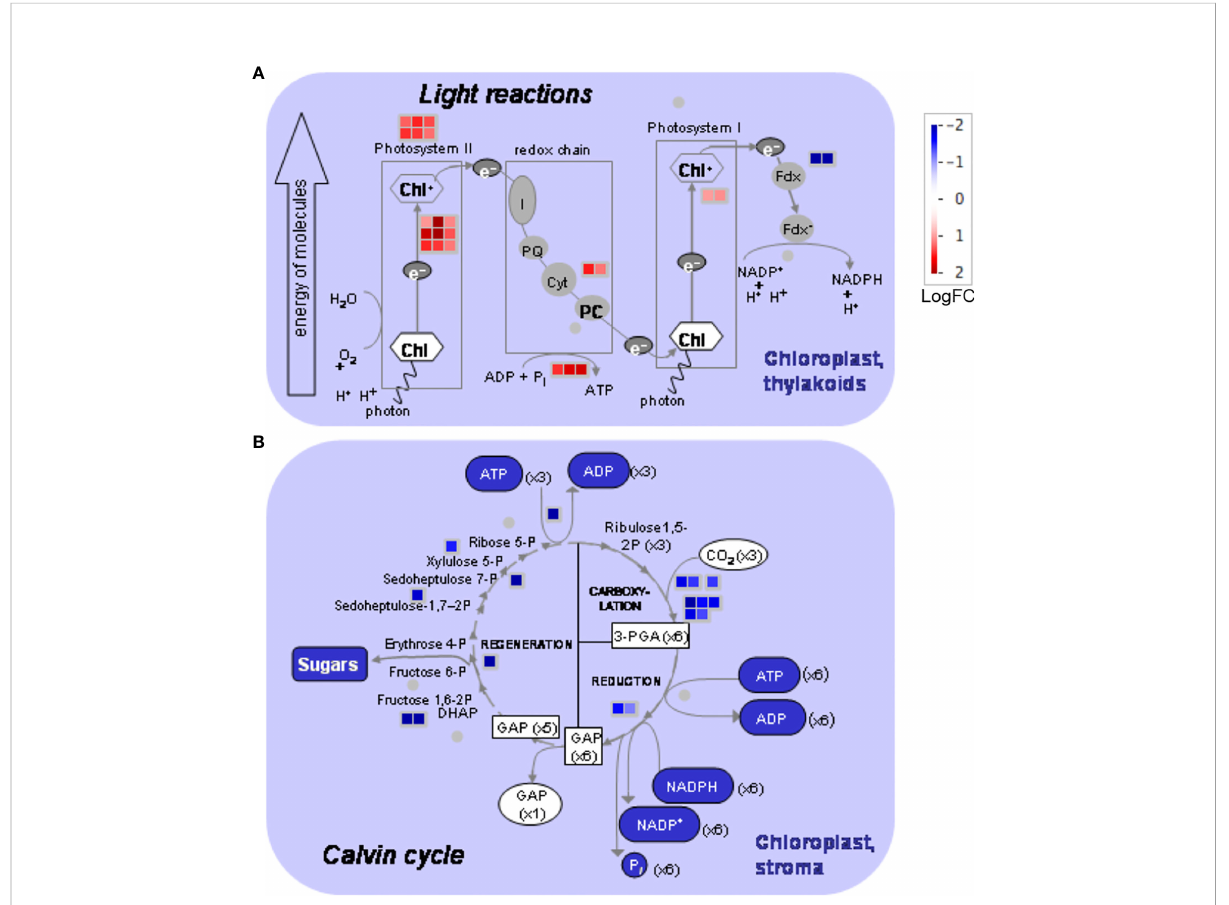
FIGURE 5 MapMan photosynthesis overview obtained from differentially accumulated proteins (DAPs) in the chloroplasts of Vitis vinifera cv. Vinhão exocarp at the mature stage (E-L 38) vs. the green stage (E-L 34). (A) Light reactions and (B) Calvin cycle. In red, proteins more accumulated in mature berries; in blue, proteins more accumulated in green berries. The MapMan fi gure was made by MapMan Version 3.6.0rc1 (https://